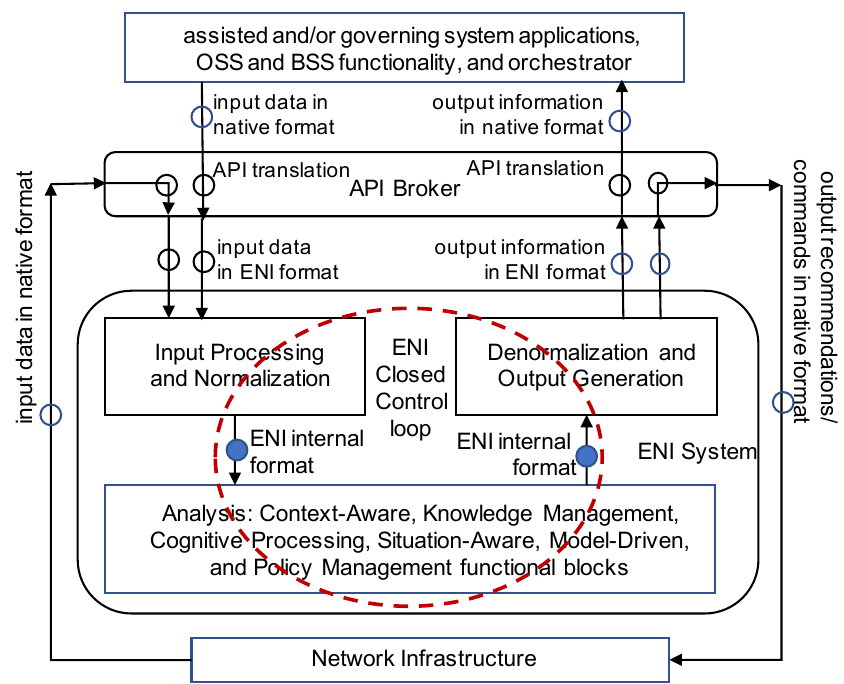
Figure 3. ETSI Experiential Networked Intelligent (ENI)